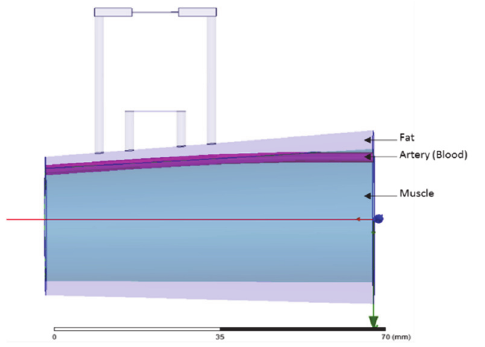
Fig.1 (b): Longitudinal view of the section